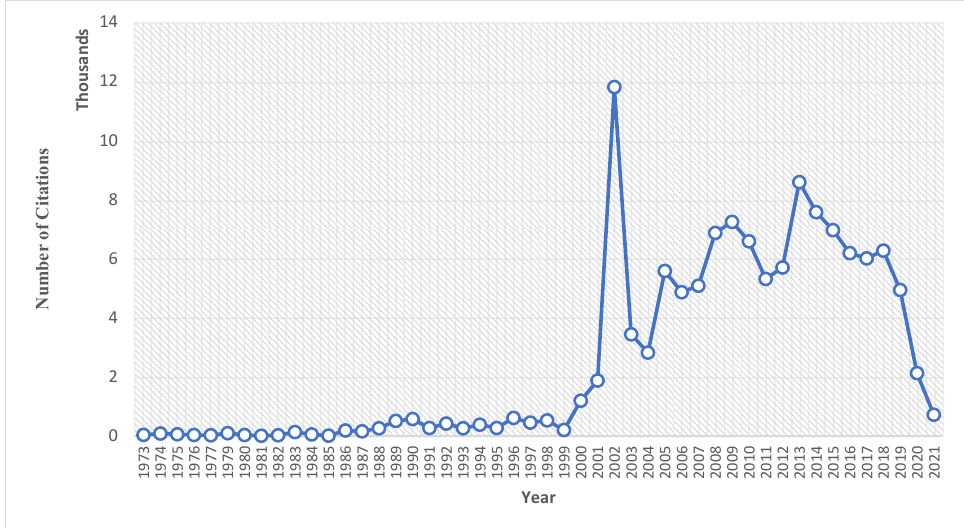
Figure 4. TCS ‐ related citations per year. Figure 4. TCS-related citations per year. Table 1. Most significant TCS-related research publications by the number of